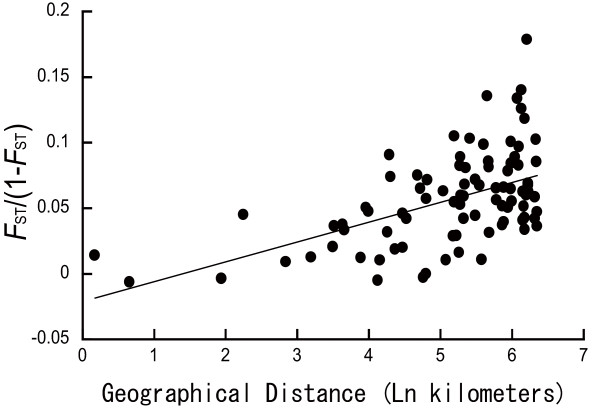
Relationships between genetic differences [FST/(1 - FST)] and geographical distance.